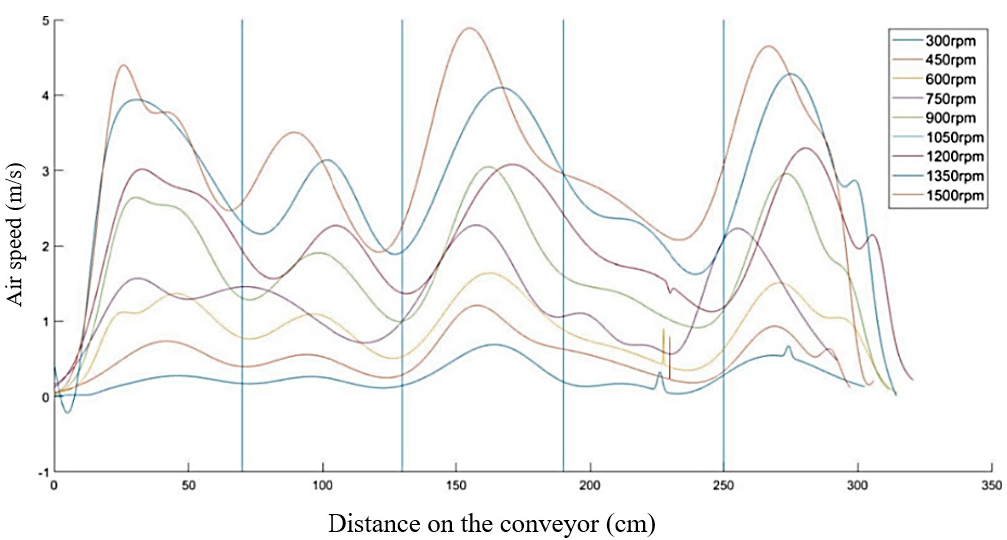
Figure 16. Distribution of the air flow speed in the scope of 300–1500 rpm along the ventilator axis: vertical lines (axis Y).